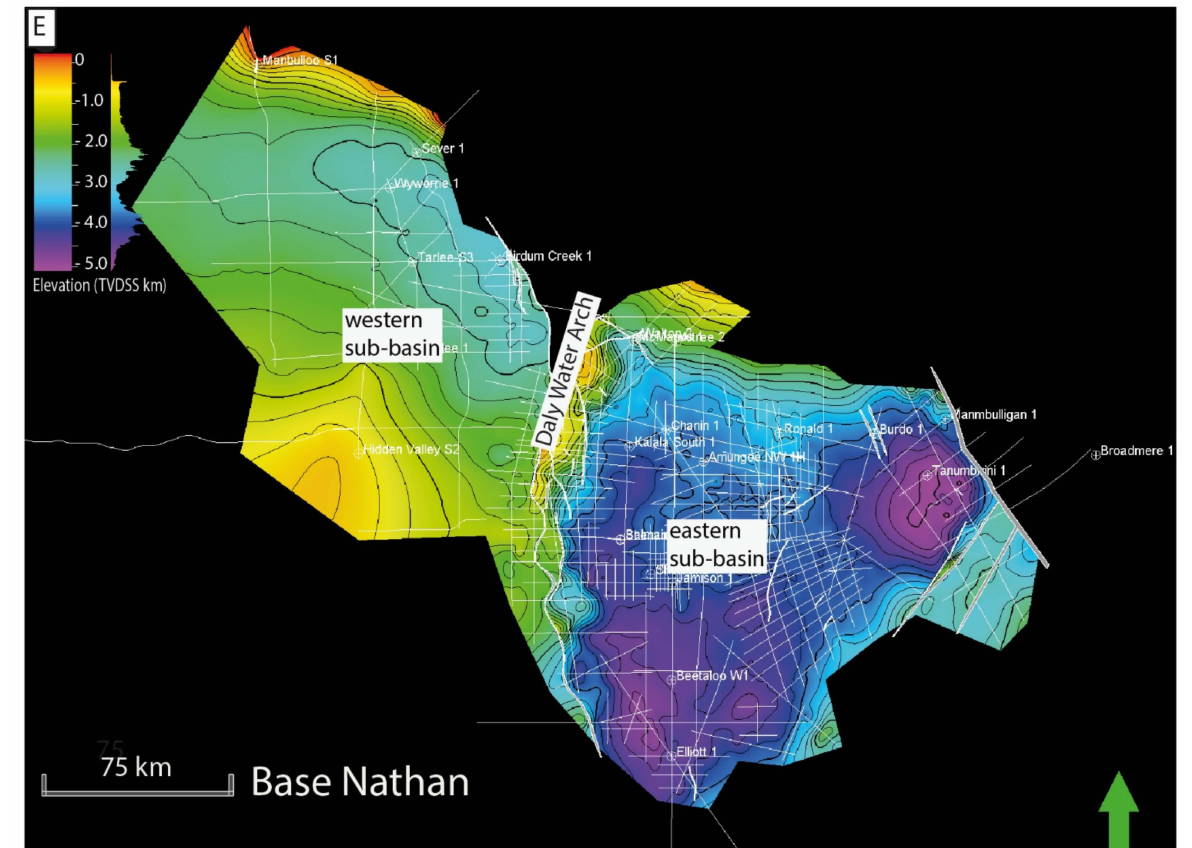
Figure 5. Depth-converted structural maps (TVDSS, m) interpreted in the Beetaloo Sub-basin for five horizons and fault network with a focus on the heritage faults reactivated post-Cambrian. From shallow to depth: ( A ) Base Cambrian; ( B ) Top Moroak Sandstone; ( C ) Lower Velkerri Formation; ( D ) Base Roper Group; ( E ) Base Nathan Group. The fault network is in bold white, the seismic lines in